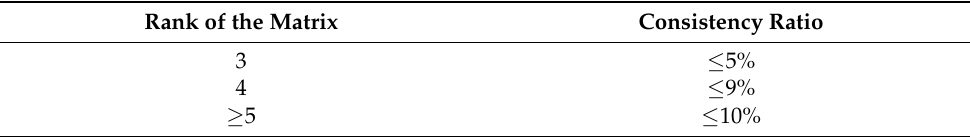
Table 4. Values of the Consistency Ratio, according to the rank of the matrix.